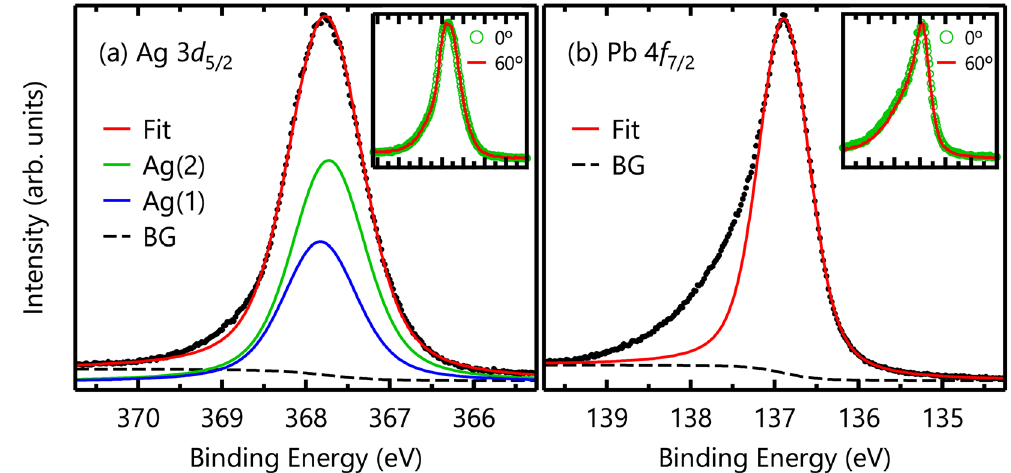
Figure 2. ( a ) Ag 3 d 5/2 and ( b ) Pb 4 f 7/2 core-level spectra of Ag 5 Pb 2 O 6 . Red lines represent results fitted by symmetric Lorentzian peaks. The insets show the takeoff-angle dependence in each spectrum. The negligible differences imply that there are no surface states in either spectra.